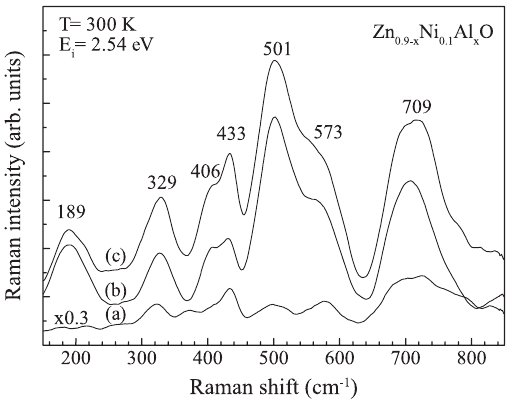
Fig. 6 Room temperature Raman backscattering spectra of the nanocrystalline Zn 0.9-x Ni 0.1 Al x O nanopowders.